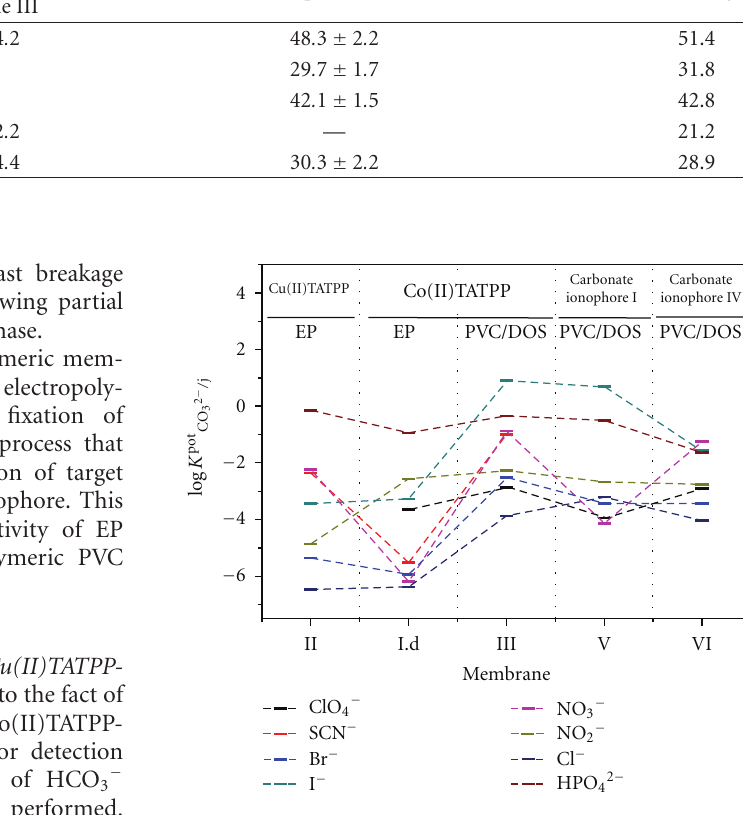
Figure 5: The comparison of the selectivity coe ffi cients of electropolymerized (EP) and solvent polymeric membranes (PVC/DOS) containing Co(II)- and Cu(II)TATPP and TFAP derivatives (commercially available carbonate ionophore I and IV). Selectivity coe ffi cients were evaluated by SSM method, the theoret- ical Nernstian slope of 29mV/pCO 3 was used in calculations.